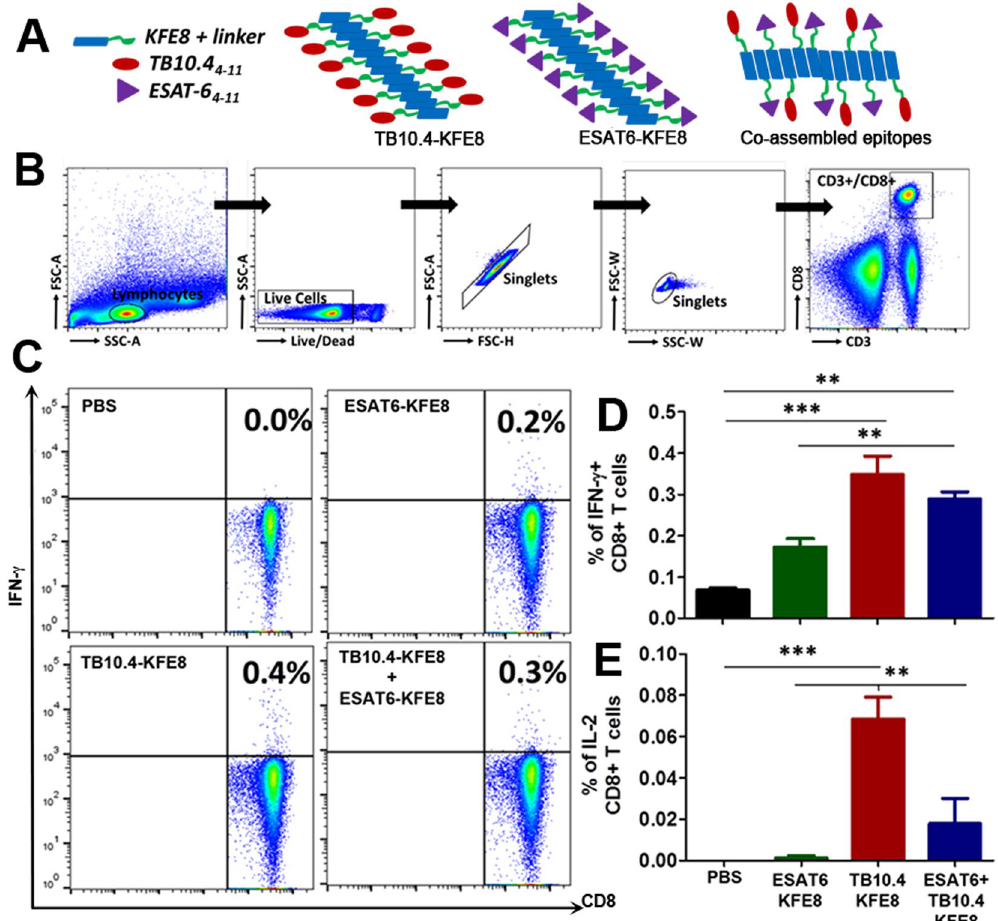
responses. Schematic shows self-assembly of single or dual epitope nanofiber formulations ( A ). Gating strategy used for identification of activated CD8 + T cells isolated from draining lymph nodes 30 days post- immunization ( B ). Representative flow plots for IFN- γ+ CD8 + T cells in mice vaccinated with single epitope or dual epitope formulations ( C ). Mean percentages ± SEM of IFN- γ+ CD8 + T cells ( D ), and IL-2 + CD8 + T cells ( E ) measured ex vivo in lymph nodes of mice vaccinated with TB10.4 or ESAT6 nanofibers or co-assembled nanofibers. Data is representative of two independent experiments with similar results and *** p < 0.001, ** p < 0.01 by one-way ANOVA with multiple comparisons of